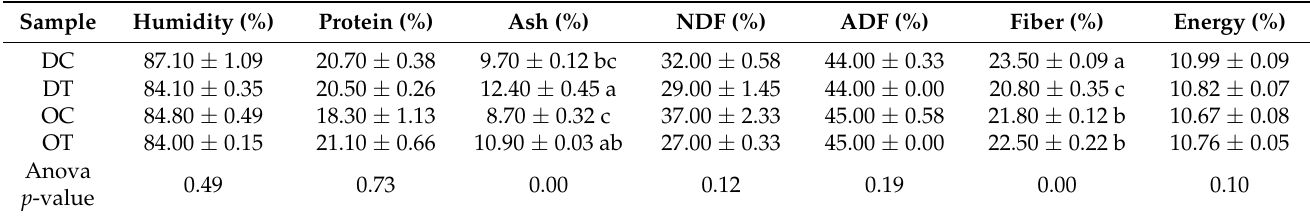
Table 9. Nutritional composition of the wheat